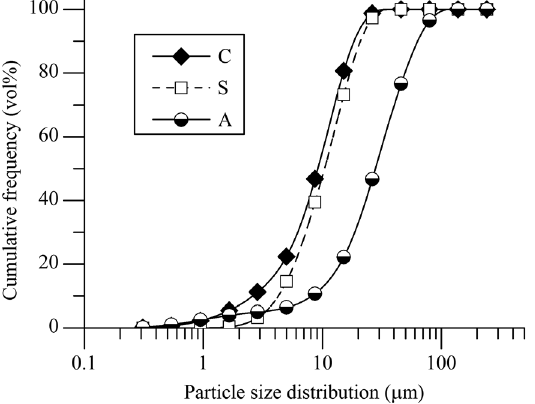
Figure 2 Particle size distributions of the three fillers.